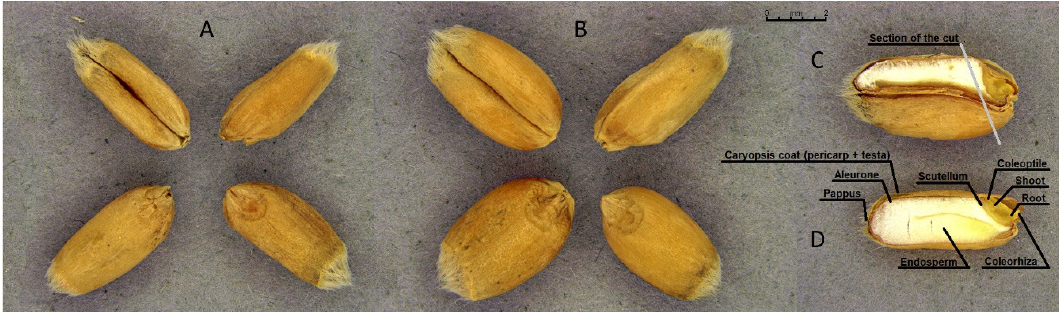
Figure 1. Selection of dry seeds of winter wheat ( Triticum aestivum ) based on seed size expressed as length, width, and thickness: ( A ) Small seeds; ( B ) Big seeds. Cross-sections of imbibed seeds 8 h after seeding on moistened filter paper: ( C ) Longitudinal section of a big seed with marked area of cut (gray line), implemented during embryo collection for analysis of phytohormones; ( D ) Longitudinal section of a small seed with marked names of the seed’s organs and tissues.